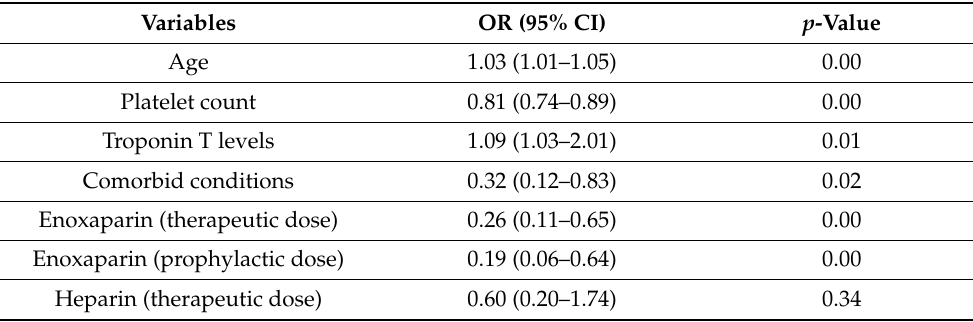
Table 2. Table showing factors affecting the outcomes of moderate to severe COVID-19 patients according to Cox proportional hazards regression analysis.